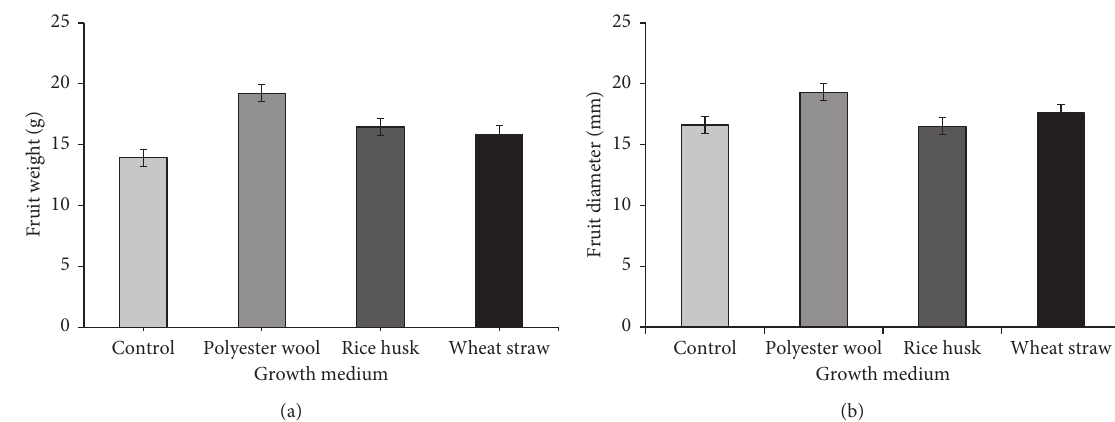
Figure 3: Effect of different growth substrates on (a) fruit weight g and (b) fruit diameter (mm) of strawberry cv. Chandler. Vertical bars indicate standard error of means ( ± SEM) for three